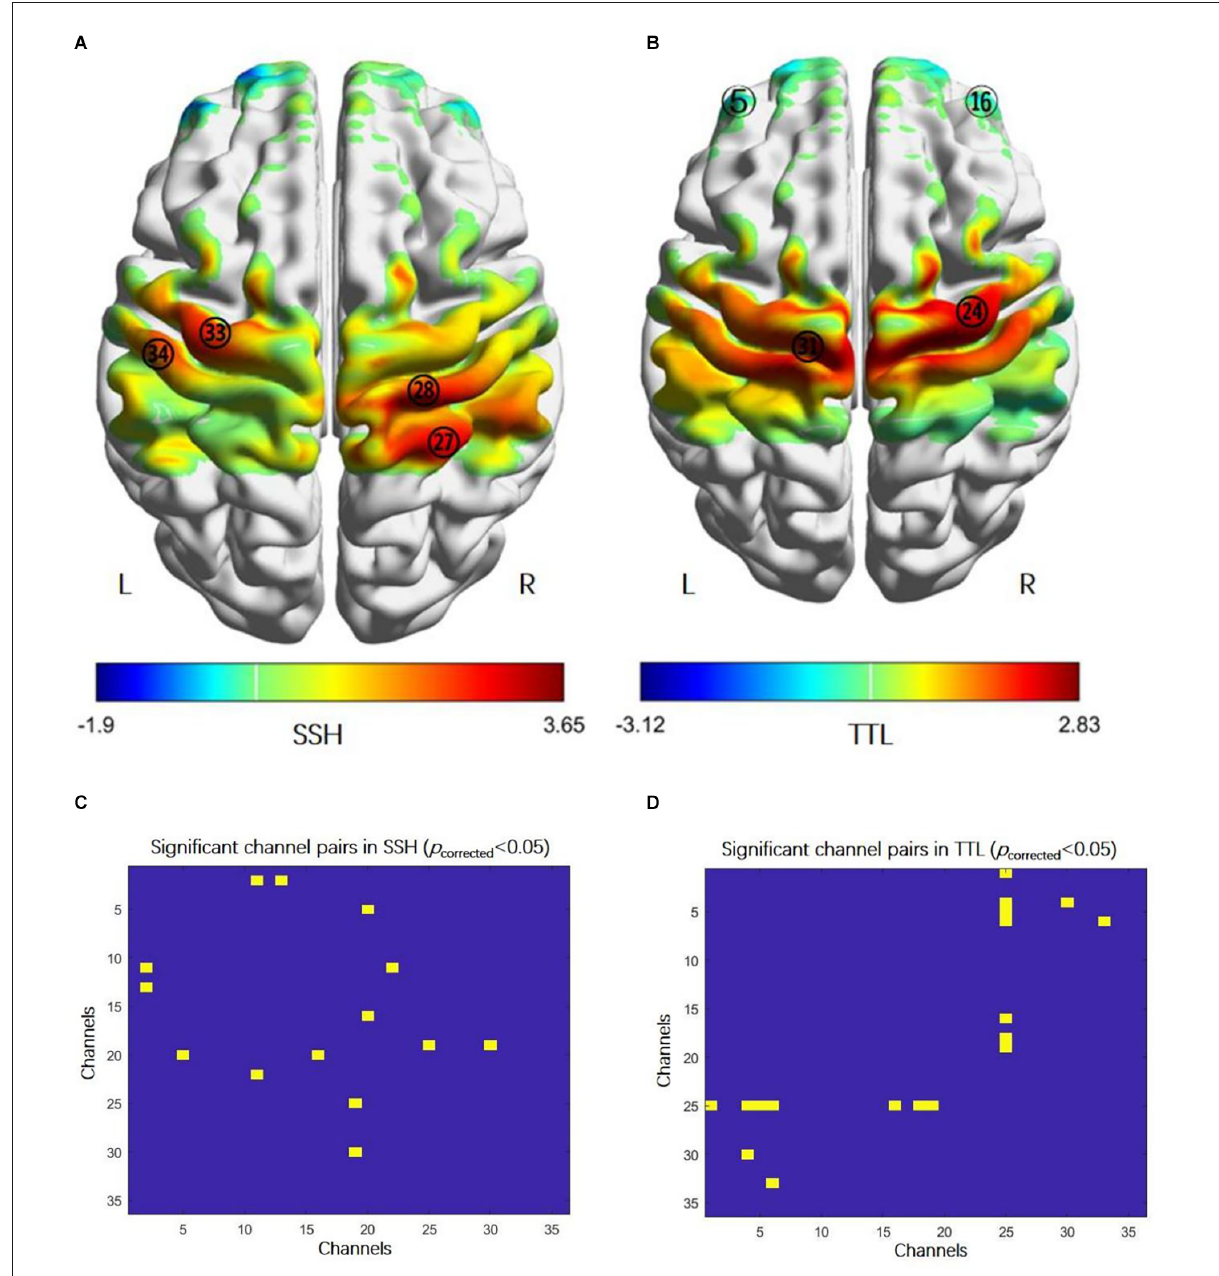
FIGURE2 Cortical activation and functional connectivity in acupuncture manipulation. (A) The activation regions: the bilateral primary motor cortex (MI, CH28 and CH33), the right somatosensory association cortex (CH27), and the left primary somatosensory cortex (CH34) (paired t -test, p < 0.05, FDR correction). (B) The activation regions: the bilateral prefrontal cortex (PFC, CH5, and CH16) and the bilateral MI (CH24 and CH31) (paired t -test, p < 0.05, FDR correction). (C) FC enhanced between: the right and left prefrontal cortex (PFC, CH5-CH20, and CH16-CH20), the right PFC (CH2-CH11, CH2-CH13), the left PFC and the right primary somatosensory cortex (CH11-CH22), the right PFC and the right primary somatosensory cortex (CH19-25), and the right PFC and the left primary somatosensory cortex (CH19-CH30) (paired t -test, p < 0.05, FDR correction). (D) Higher FC between: the left PFC and the right primary somatosensory cortex (CH1-CH25, CH4-CH25, CH5-CH25, and CH6- CH25), right PFC and the right primary somatosensory cortex (CH16-CH25, CH18-CH25, and CH19-CH25), the left PFC and the left primary somatosensory cortex (CH4-CH30), and the left PFC and the left primary motor cortex (CH6-CH33) (paired t -test, p < 0.05, FDR correction). Abbreviations: FC, functional connectivity; SSH, Shaoshanhuo reinforcing method; TTL, Toutinaliang reducing method.